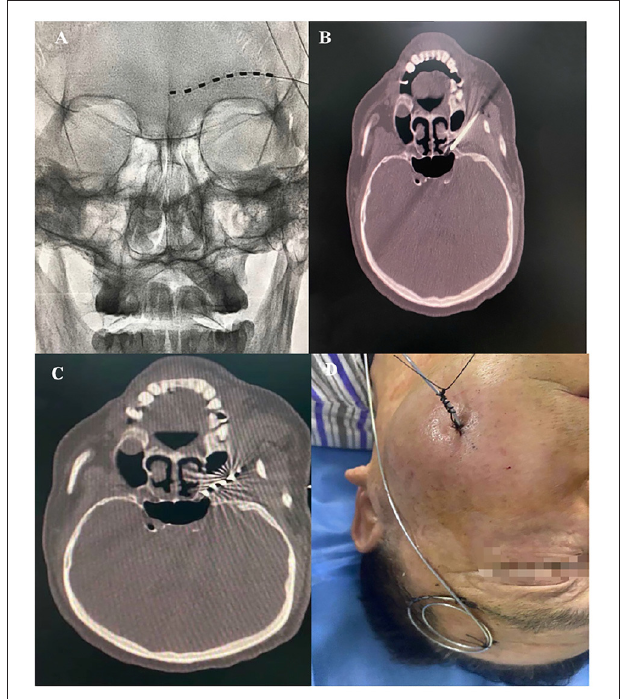
FIGURE 1 | (A) CT-guided PRF on the Gasserian ganglion. (B) High cervical SCS at the C1-C2 level. (C) A 14-G needle inserted at the level of the right zygomatic bone. (D) High cervical SCS combined with infraorbital nerve (ION) PNS.